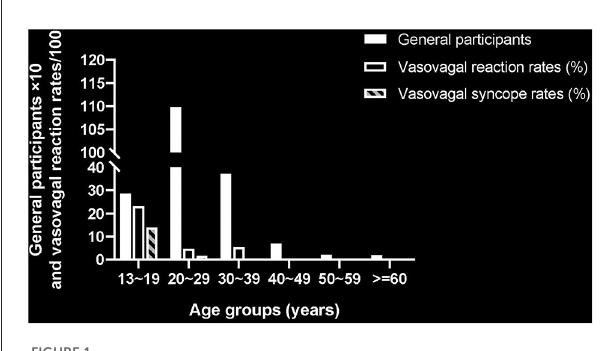
earlobe piercing. The occurrence of vasovagal reactions was 10.5% (196/1,866) and the incidence of syncopal reaction was 3.11% (58/1,866). The average age of the reactors without syncope ( n = 138) was 20.58 years (range 15 to 33 years). Dizziness (31%), pallor (30%), and nausea (14%) were the three most common